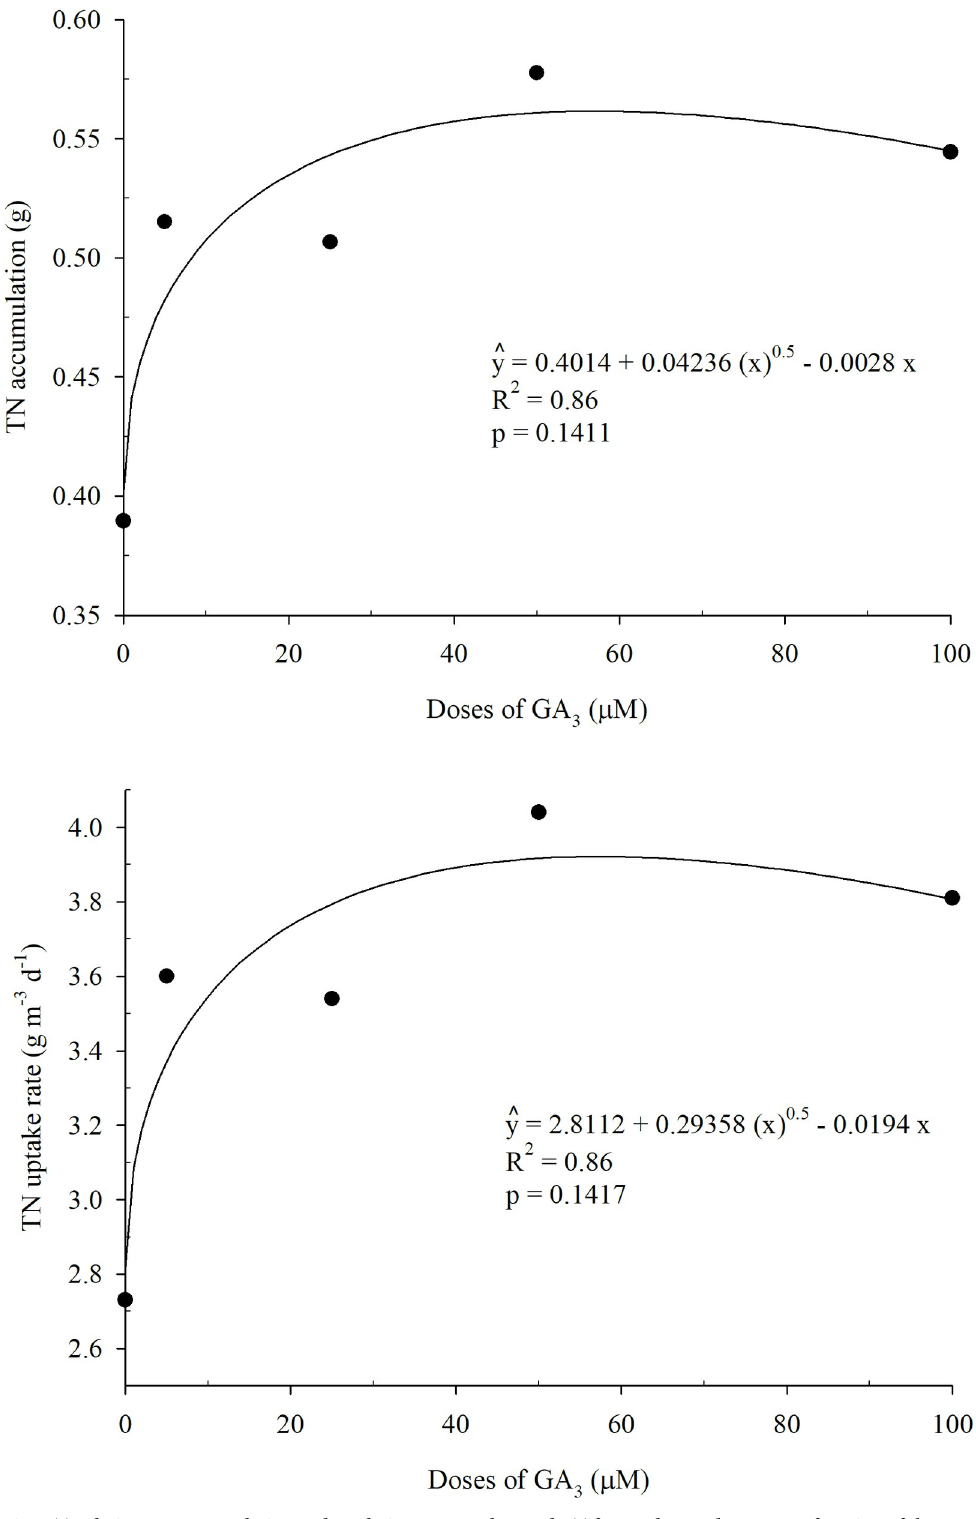
Fig 7. Total nitrogen accumulation and total nitrogen uptake rate by Tifton 85 bermudagrass as a function of the different doses of GA 3 (1st